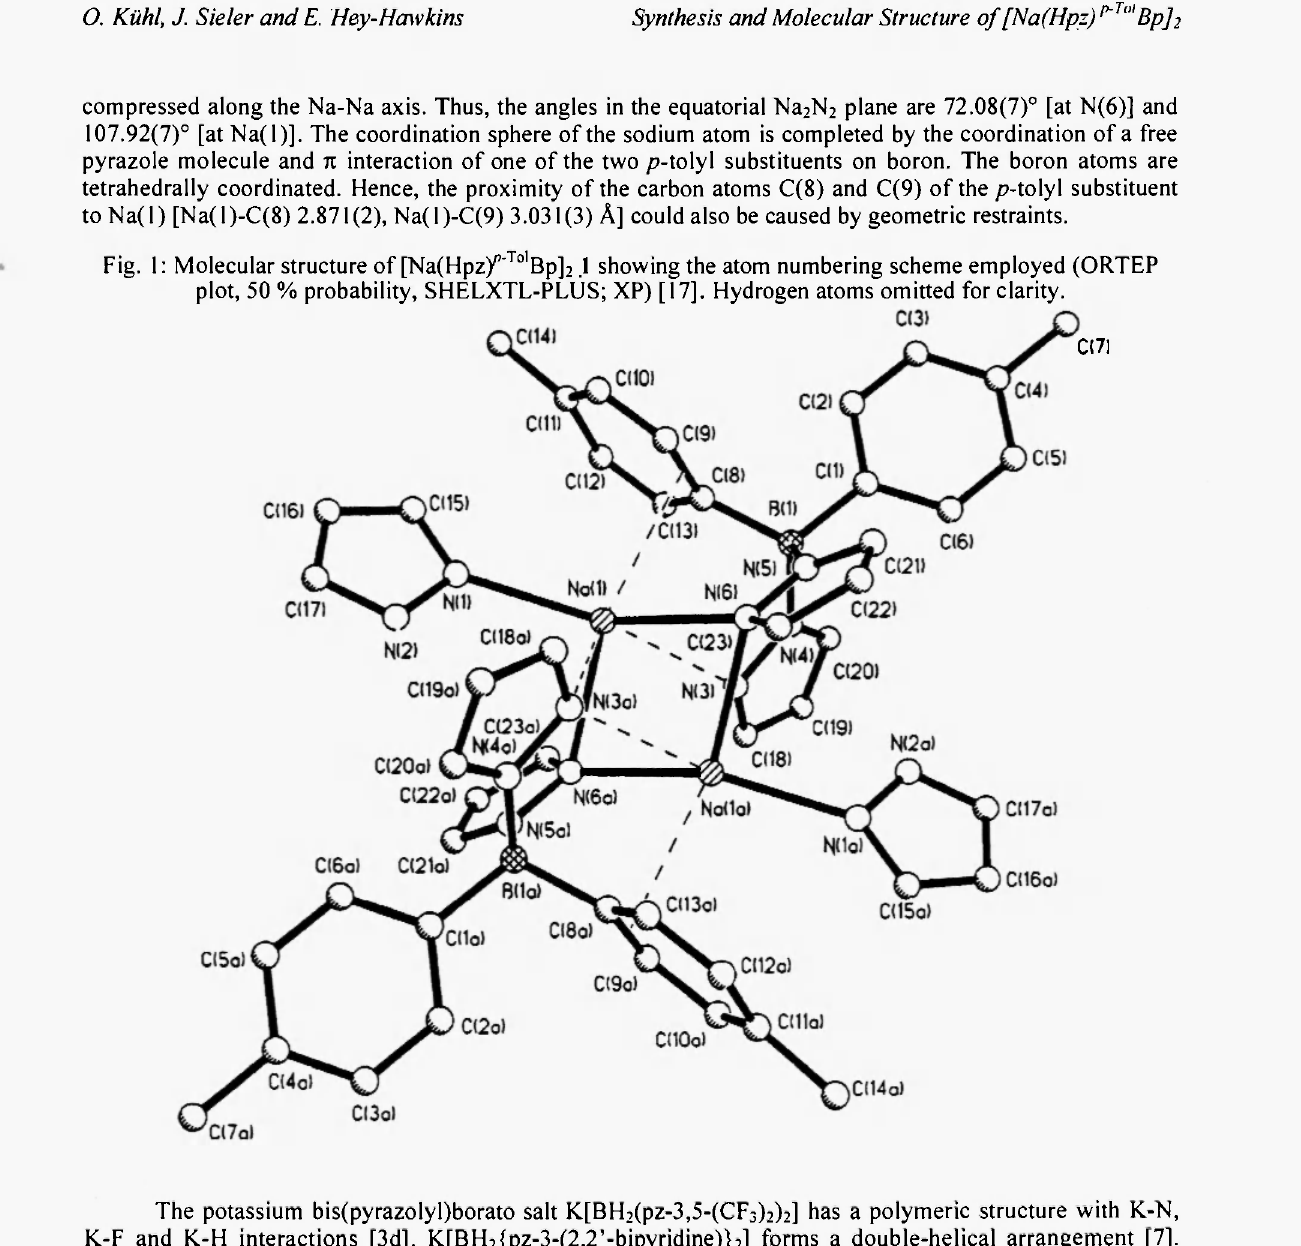
Fig. 1: Molecular structure of [Na (Hpzy _Tol Bp] 2 I showing the atom numbering scheme employed (ORTEP plot, 50 % probability, SHELXTL-PLUS; XP) [17]. Hydrogen atoms omitted for